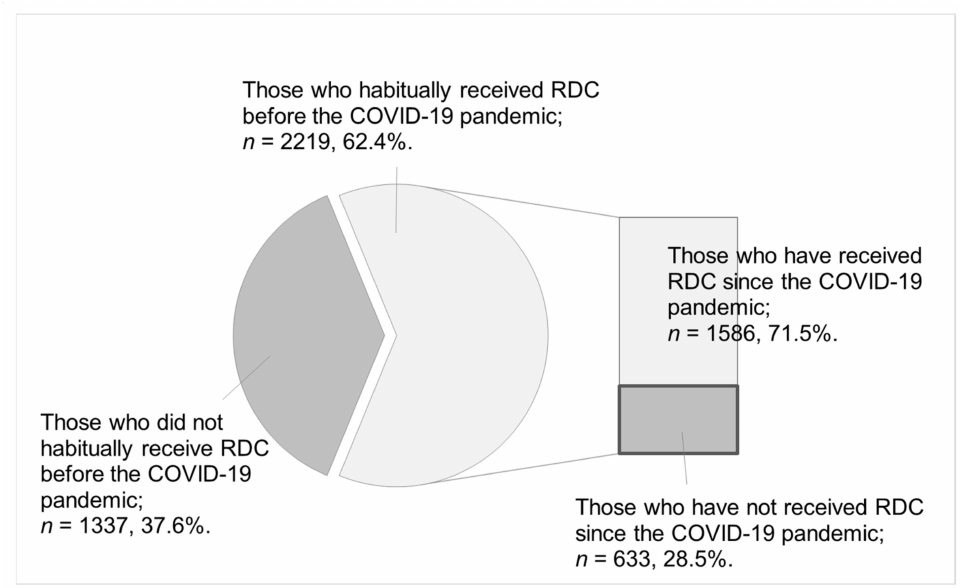
Figure 1. Status of participants receiving RDCs since the COVID-19 pandemic. Note. RDC = regular dental checkup; COVID-19 = coronavirus disease